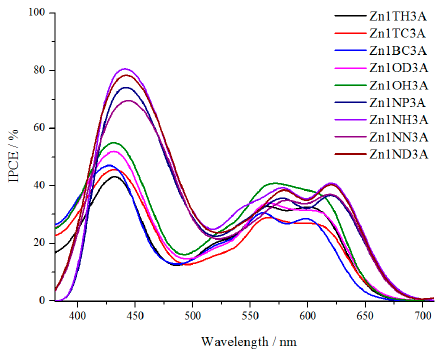
Figure 6. The incident photon ‐ to ‐ current efficiency spectra for 1D ‐π‐ 3A porphyrin sensitizers.